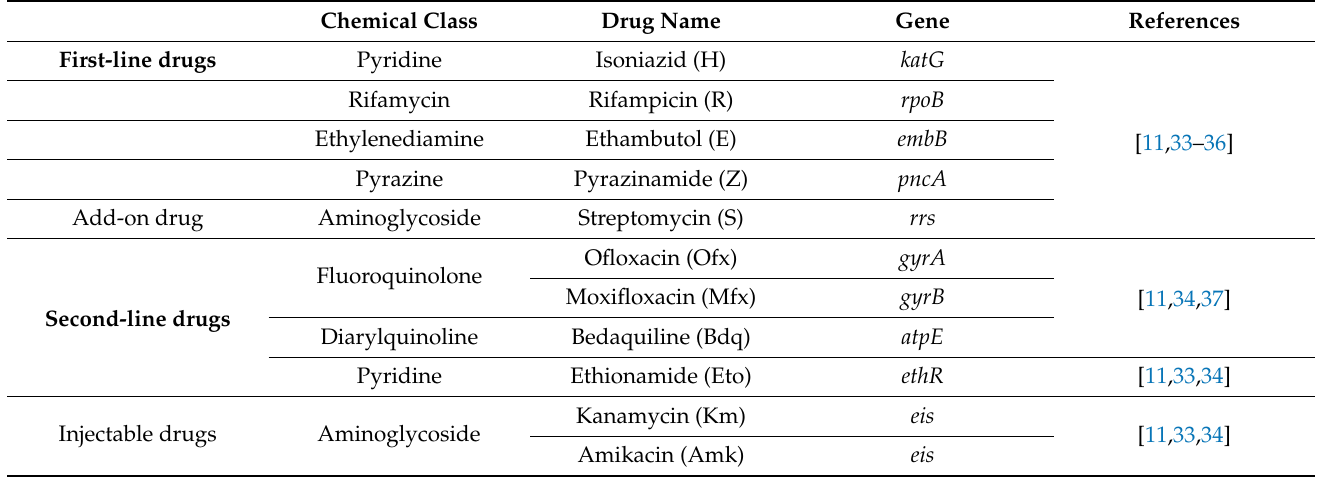
Table 2. Antibiotic resistance genes selected for this study and the antibiotics that they code resistance